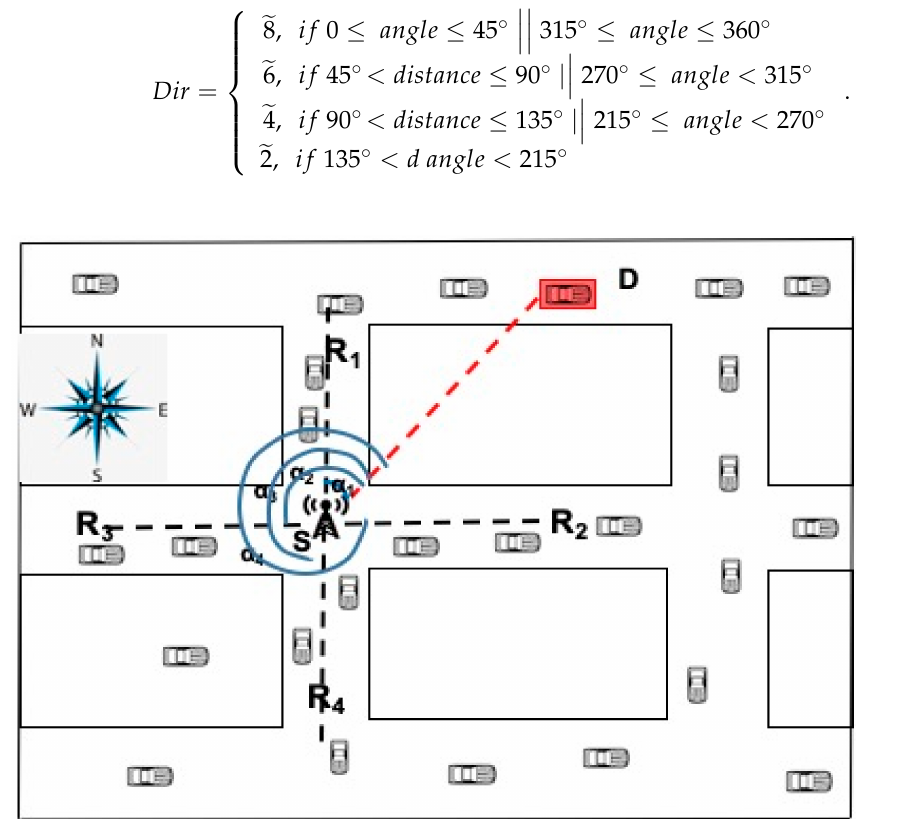
Figure 2. An example of the direction